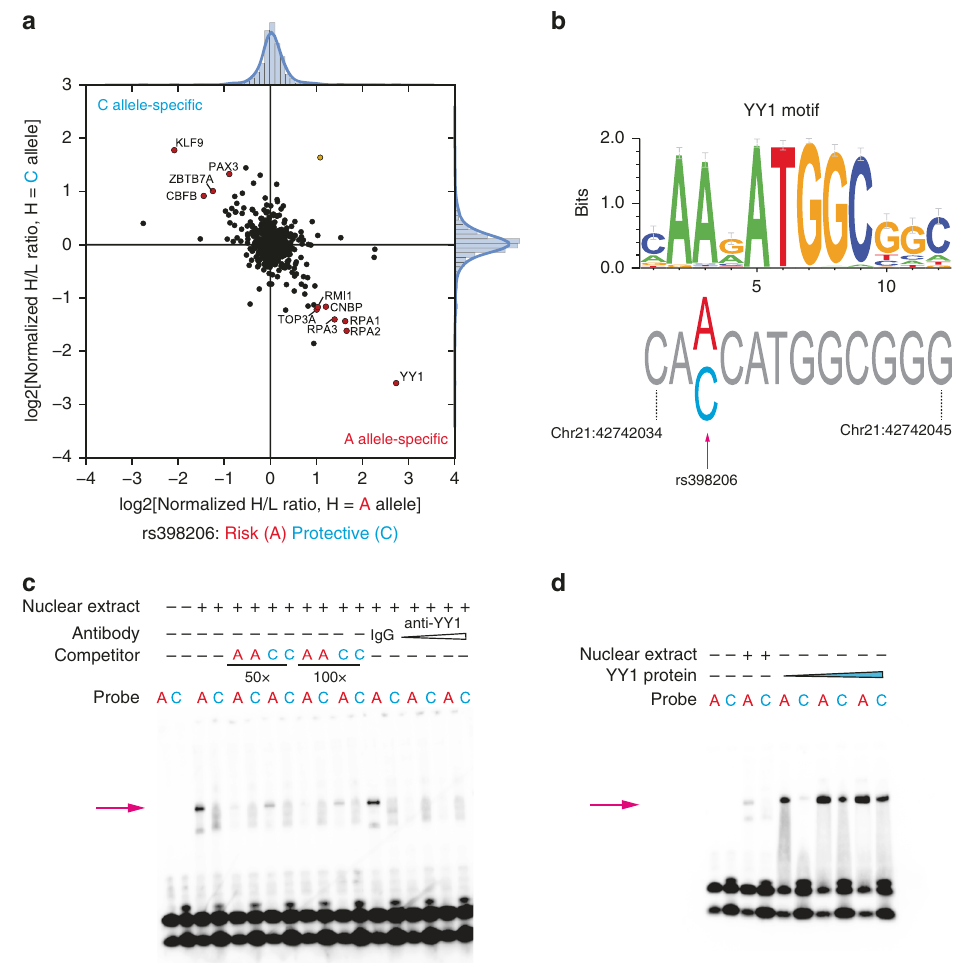
double-stranded DNA probes with A (risk) or C (protective) alleles. A-allele speci fi c interacting proteins are shown in the bottom right quadrant, and C- allele speci fi c interactors in the top left quadrant. Using label-swapping of high(H)-mass or low(L)-mass label, the A-bound/C-bound ratio is shown on the x -axis, and the C-bound/A-bound ratio on the y -axis. Proteins passing the inter-quartile >3 cutoff for both axes are color-coded for consistent (red circle) and inconsistent (yellow circle) direction from label-swapping. Names of consistently identi fi ed proteins are shown. b YY1 binding motif is shown as a position weight matrix at the top (motif obtained from HOCOMOCO database and plotted using weblogo3). The genomic sequence surrounding rs398206 is shown at the bottom with the risk-associated A allele matching the consensus YY1-binding motif. Genomic positions are hg19. c – d EMSAs using 21 bp ( d ). Antibody super-shift using anti-YY1 antibody is shown at the last lanes of c , where the A-speci fi c band (arrows) is diminished. Representative sets from three replicates ( c ) and one replicate ( d ) are shown. Source data are provided as a Source Data fi